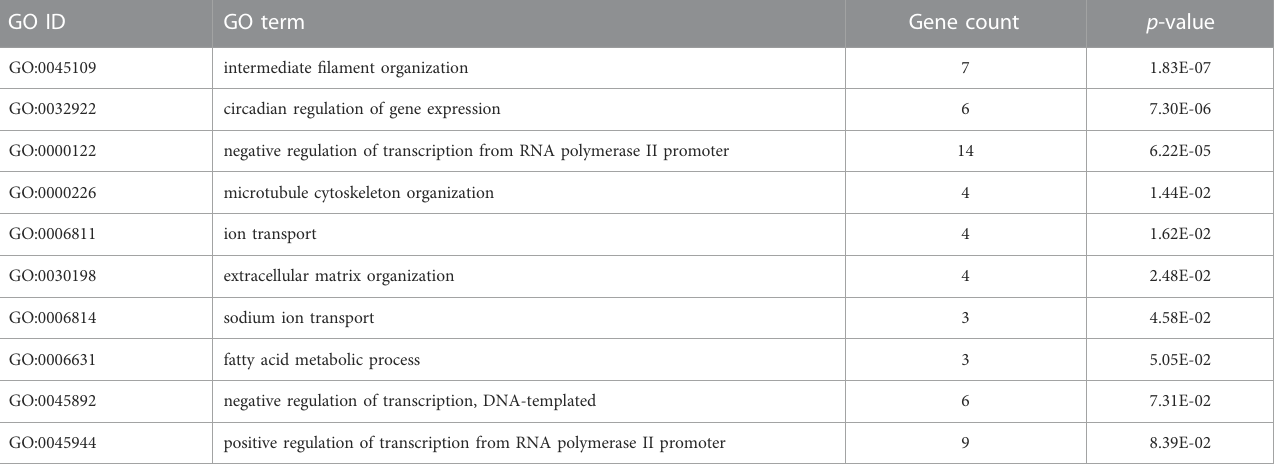
TABLE 3 Biological process GO terms of differentially expressed transcripts in common between the vehicle vs. eplerenone groups. GO ID GO